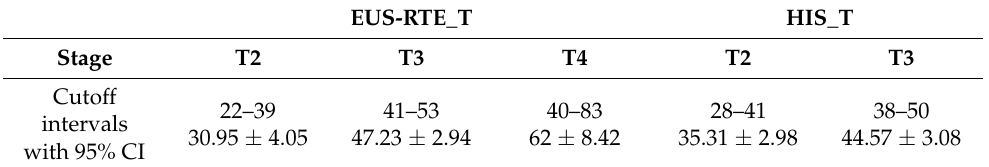
Table 4. Cutoff stiffness for the T stage evaluated by EUS-RTE and histological analysis.